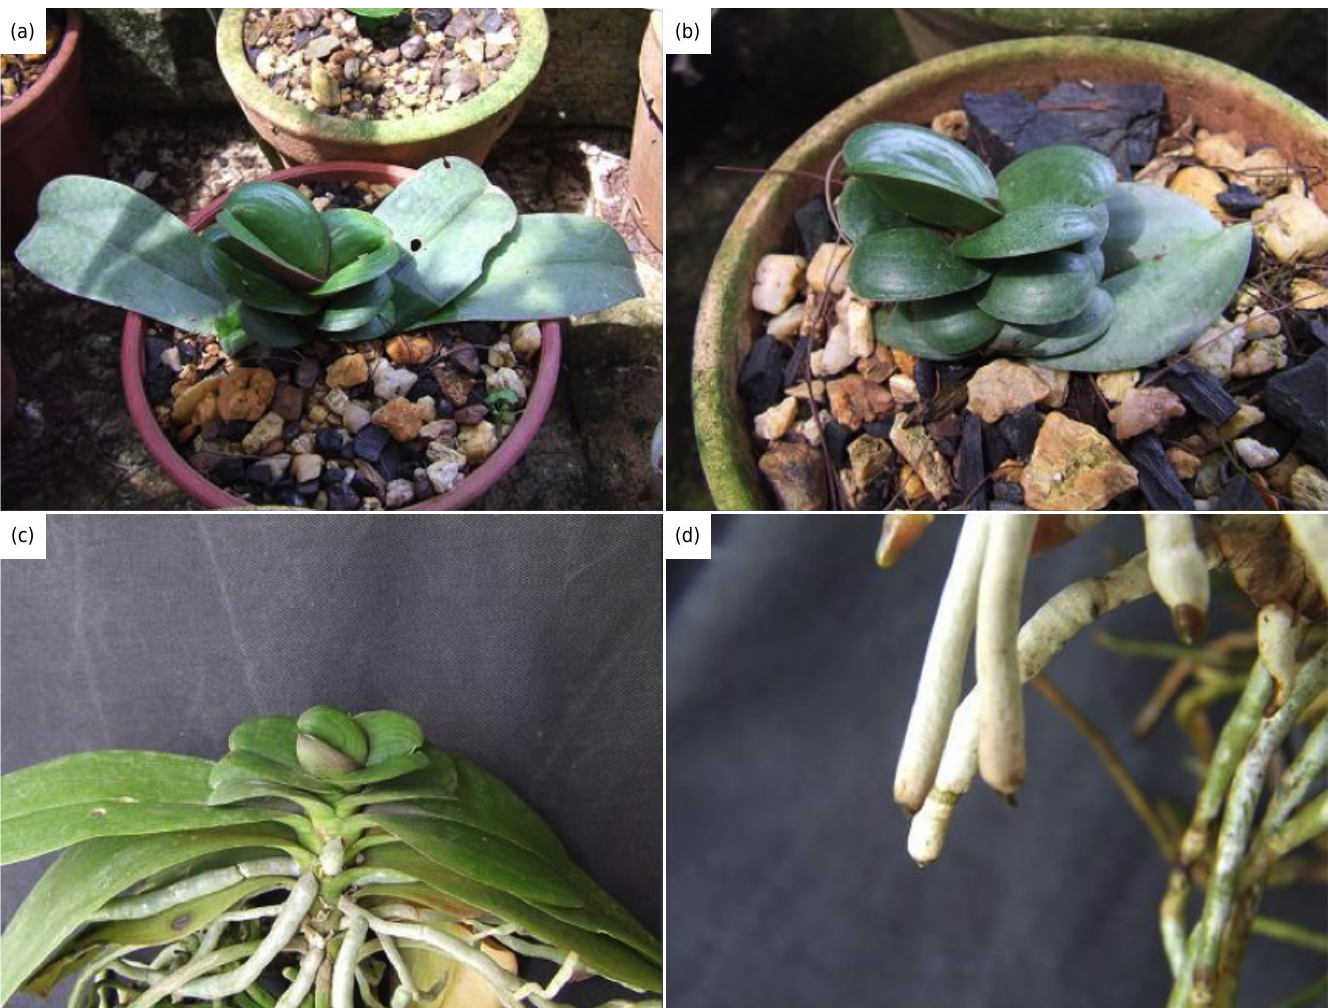
Figure 2. Visual symptom of severe Zn deficiency in plants of Phalaenopsis spp. induced by excessive supply of phosphorus in a commercial nursery, characterized by slower growth of the last leaf pair (a, b, c) and shortening of the roots (d). Source: R. F. Novais, personal